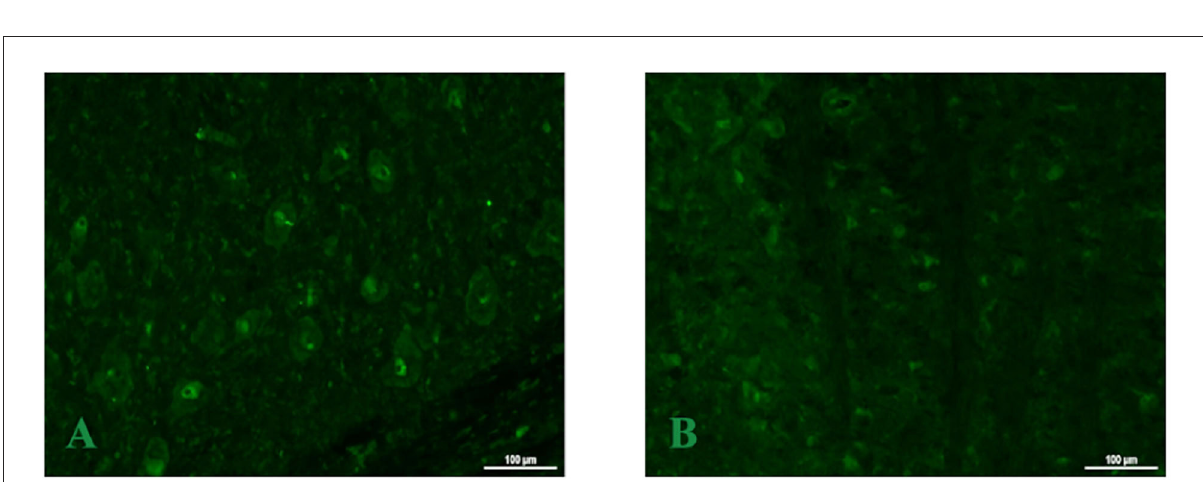
FIGURE2 Blood and cerebrospinal fluid TBA screening. The TBA method was applied to incubate the patient’s cerebrospinal fluid specimen with sections of cerebellar, hippocampal, cortical, and brainstem tissues from rats. Compared with the negative control (B) , the patient’s cerebrospinal fluid (A) was present antibodies that might have the immune reactions with the rat brainstem tissues. The image shows specific fluorescent signals, indicating that there are positive cell membrane antibodies in brainstem neurons, whereas the patient’s cerebrospinal fluid sample showed no fluorescence with rat cerebellar, hippocampal, and cortical tissue sections (data not